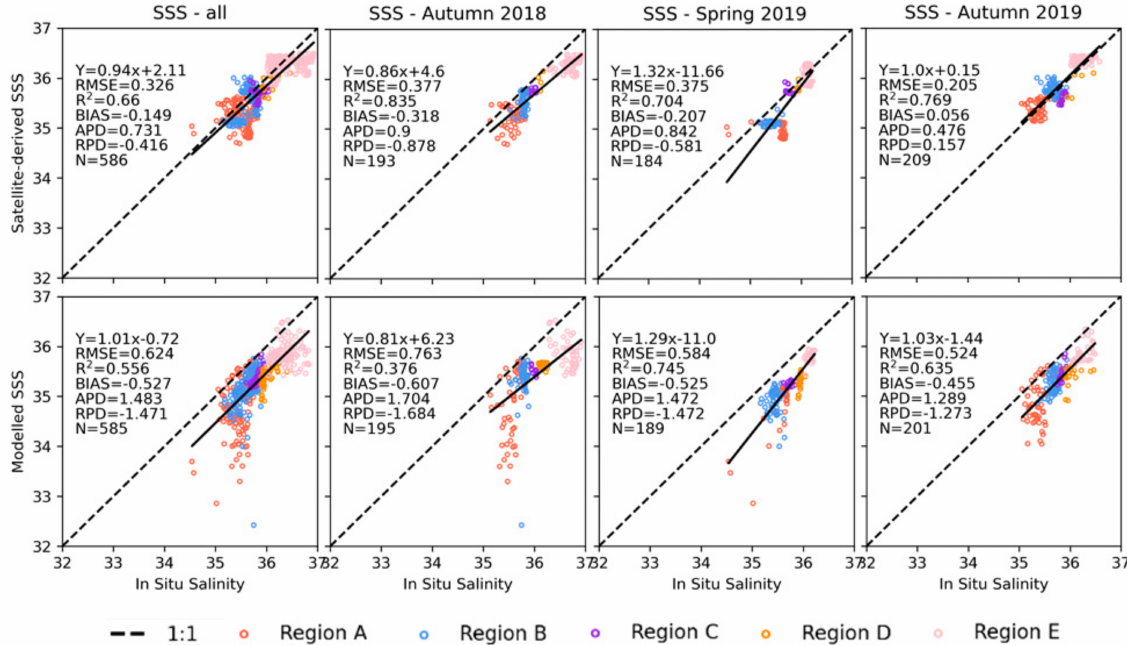
Figure 3. Comparison of the satellite– derived and the modelled sea surface salinity data with the in situ observations. Matchups plotted according to the season of the year and colored by the sampling region. 1:1 line indicates ideal correspondence. APD and RPD values are in